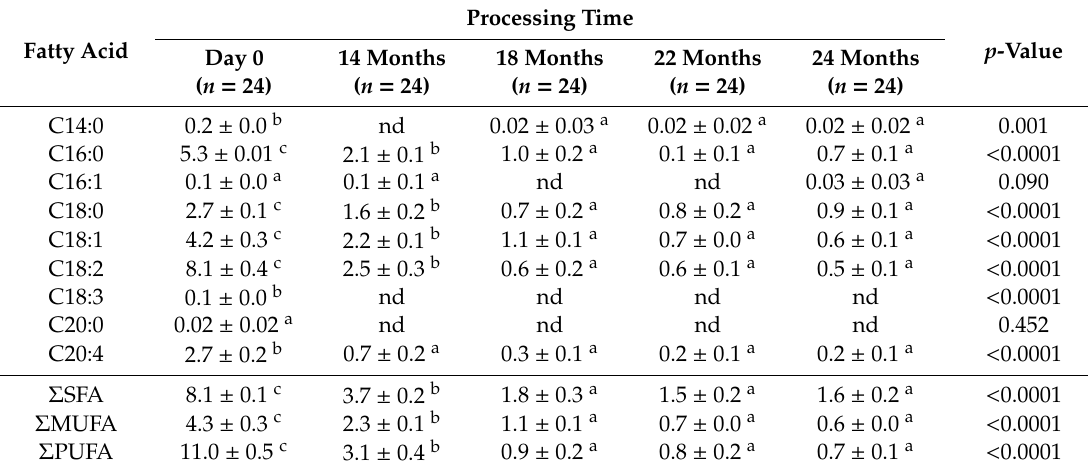
Table 3. E ff ect of processing time on fatty acids contents of polar lipids in Chato murciano